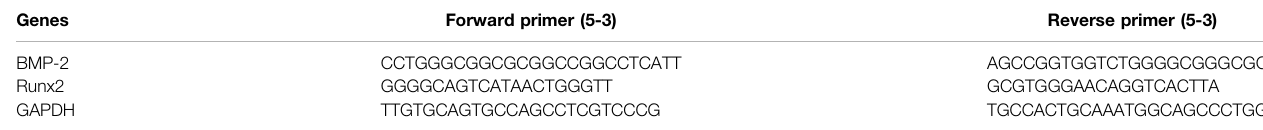
TABLE 1 | The base of primers for quantitative real-time